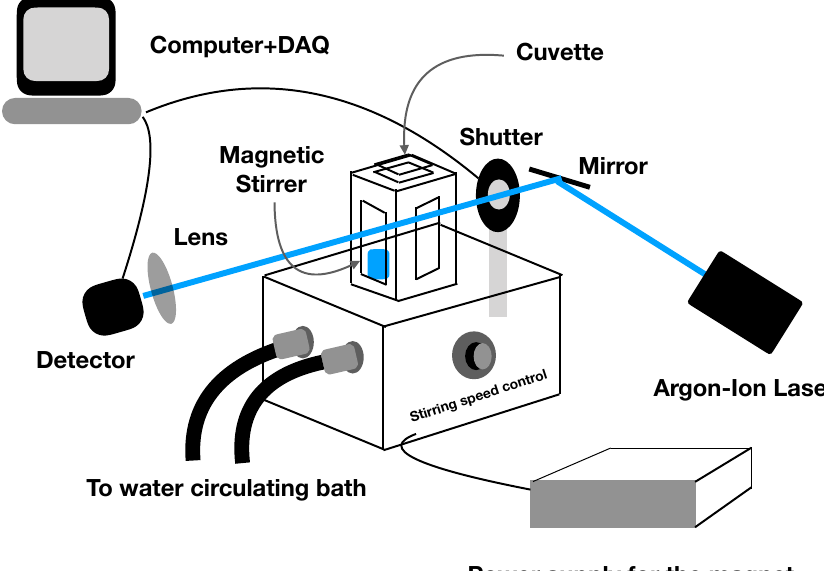
Figure 2. Schematic of the experimental setup used to measure the optical density, OD 488 , of bacteria in real